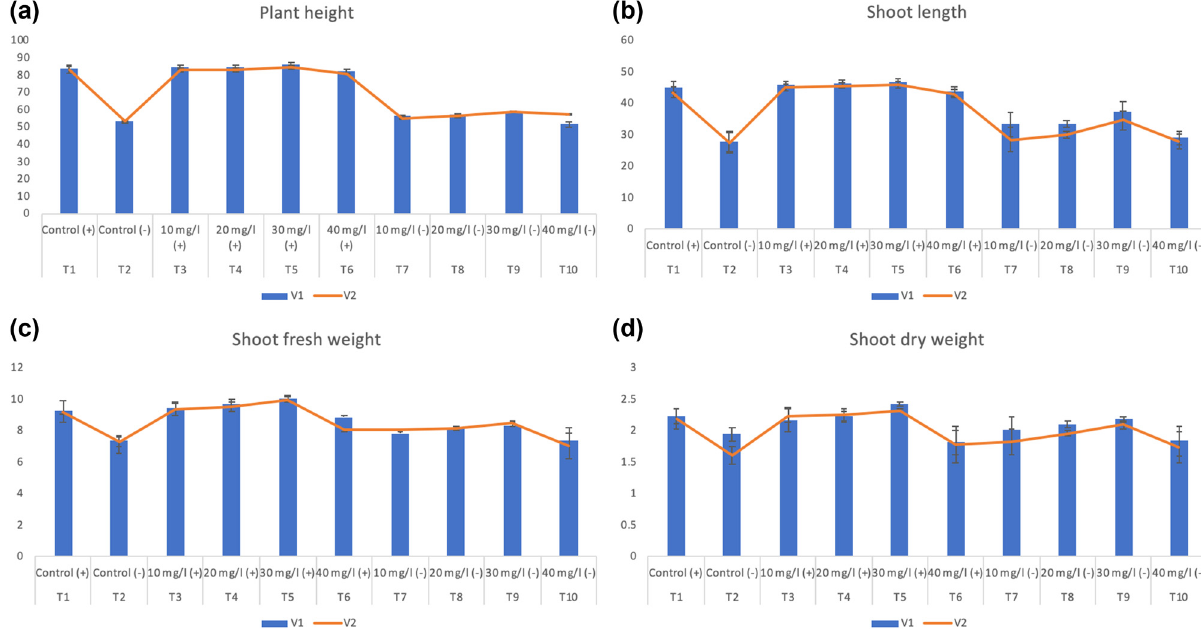
Figure 4: E ff ect of di ff erent treatments of SeNPs on ( a ) plant height, ( b ) shoot length, ( c ) shoot fresh weight, and ( d ) shoot dry